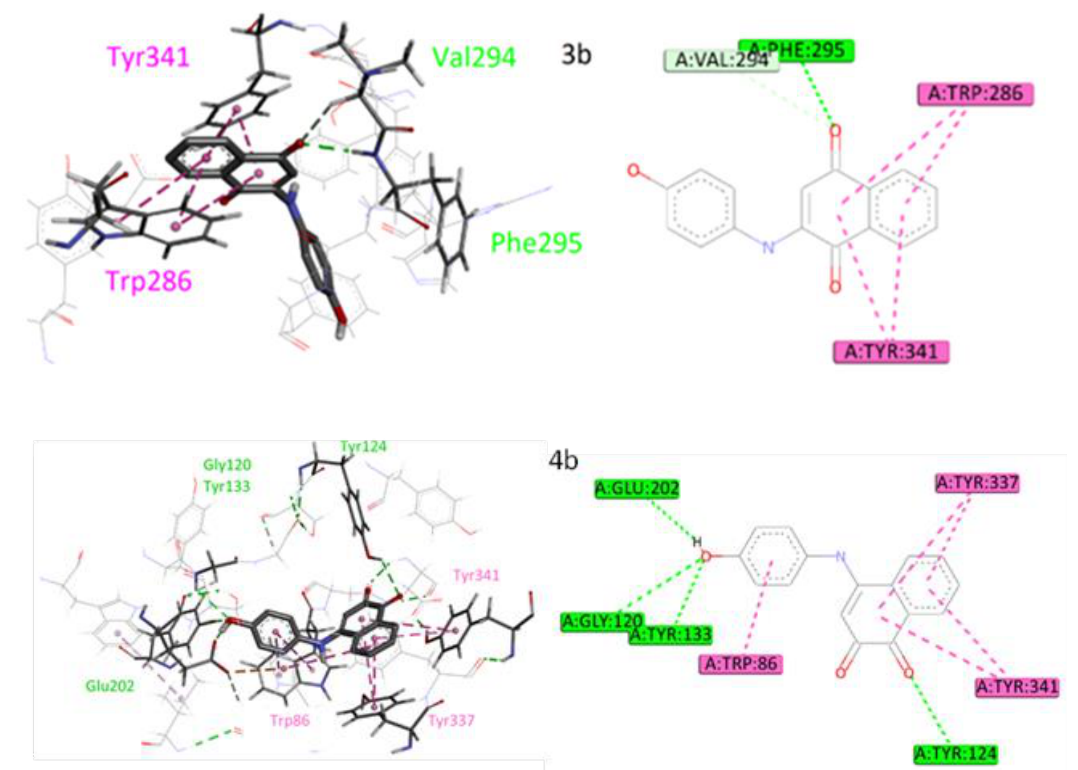
Figure 5. Binding mode prediction for compounds 3b and 4b with AChE (PDB id:4EY7) visualized in Discovery Studio, BIOVIA. Color coding: pink, π - π aromatic interaction; green, conventional hydrogen bond.